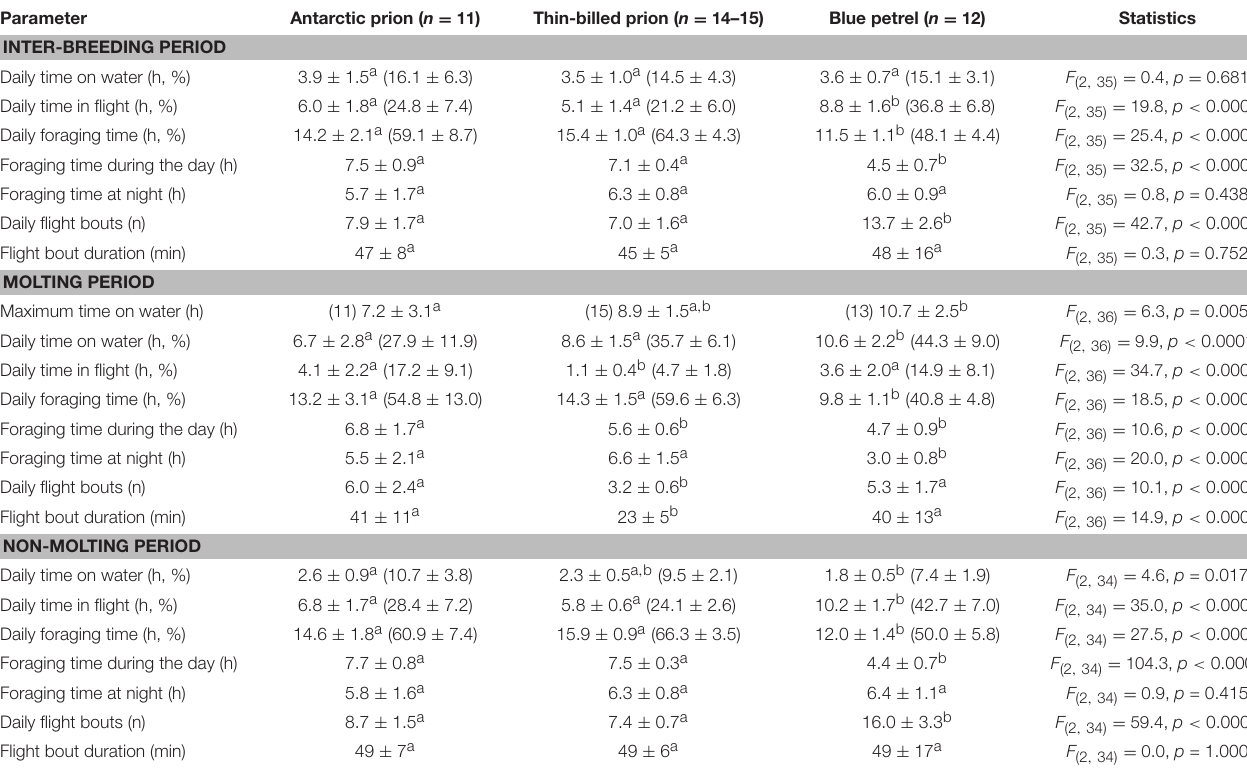
TABLE 3 | At-sea activities during the inter-breeding and molting periods of Antarctic and thin-billed prions and of blue petrels from the Kerguelen Archipelago in 2012. Parameter Antarctic prion ( n = 11 ) Thin-billed prion ( n = 14 –15) Blue petrel ( n = 12